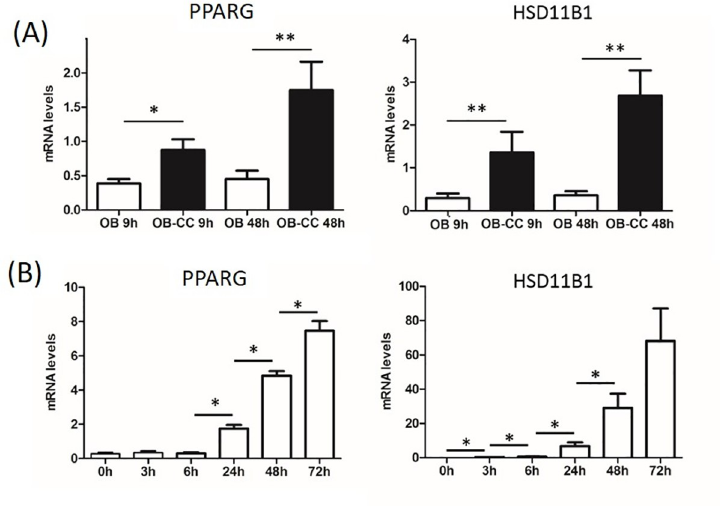
Fig 1. Coculture induced the conversion of osteoblasts into preadipocytes. (A) PPARG (Peroxisome Proliferator Activated Receptor Gamma) and HSD11B1 (Hydroxysteroid 11-Beta Dehydrogenase 1) mRNA expression levels in OB and OB-CC after 9 h and 48 h of coculture. mRNA expression levels were normalized against the signal from two housekeeping genes, PPIA (peptidylprolyl isomerase A) and YWHAZ (tyrosine 3-monooxygenase/tryptophan 5-monooxygenase activation protein). Graphs are representative of 6 independent experiments (donors A-F) performed in duplicate. Error bars are the standard deviation. � P � 0.05, �� P (0.01, cocultured osteoblasts (OB-CC) compared to osteoblasts grown alone (OB). (B) PPARG and HSD11B1 mRNA expression levels in BMSC-derived adipocytes at 0, 3, 6, 24, 48, and 72 h of differentiation. mRNA expression levels were normalized against the signal from two housekeeping genes, PPIA and RP2 (RNA polymerase II). Graphs are representative of 4 independent experiments (donors C-F) that were performed in duplicate. Error bars represent the standard deviation. � P � 0.05.